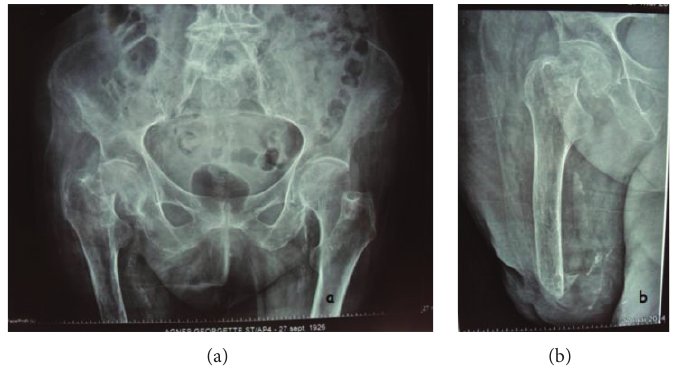
Figure 1: The X-ray of the pelvis and the hip (an anteroposterior X-ray) showing a fracture of the femoral neck.